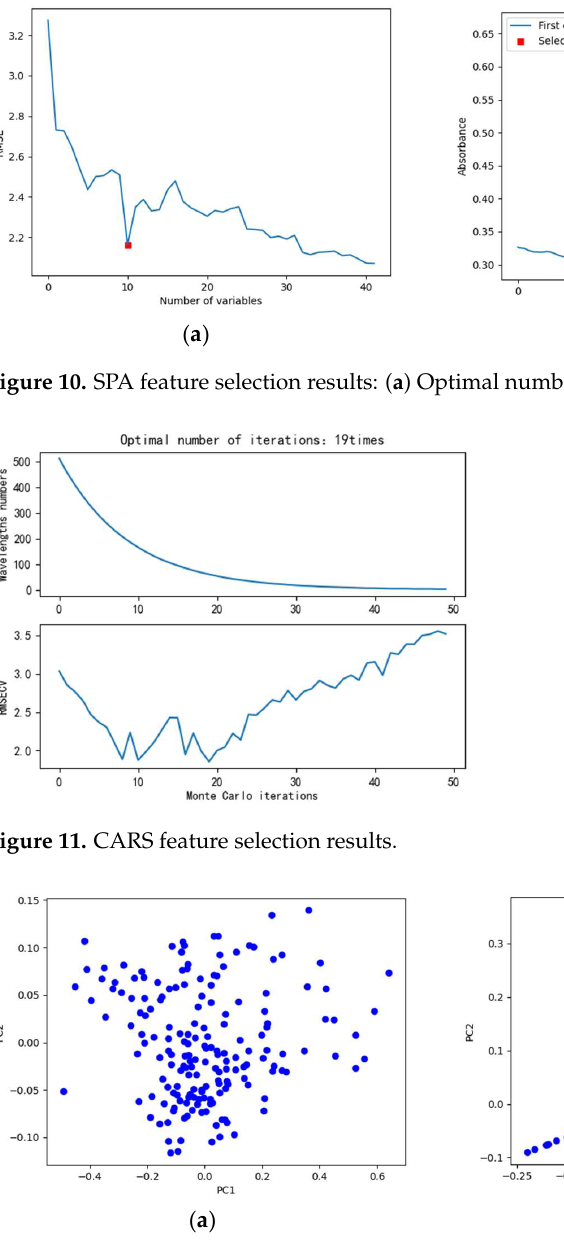
Figure 12. Distribution of principal component scores: ( a ) PCA (PC1: Variance = 60.613%, PC2: Variance = 18.077%); ( b ) CARS-LLE (PC1: Variance = 67.685%, PC2: Variance = 20.082%).